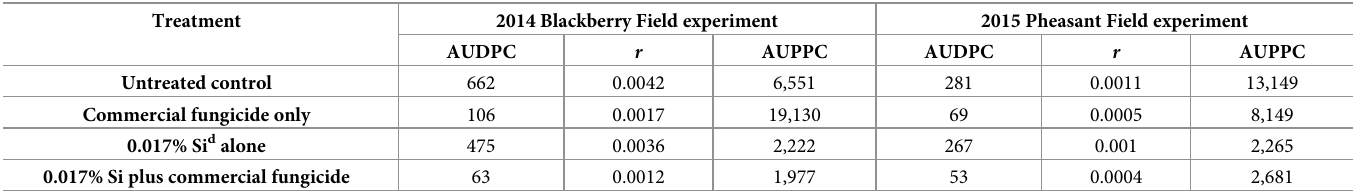
Table 2. The analysis of the severity of Podosphaera aphanis (AUDPC a & r (Apparent infection rate) b ) and Tetranychus urticae (AUPPC c ) for the treatments in 2014 and 2015 experiments.